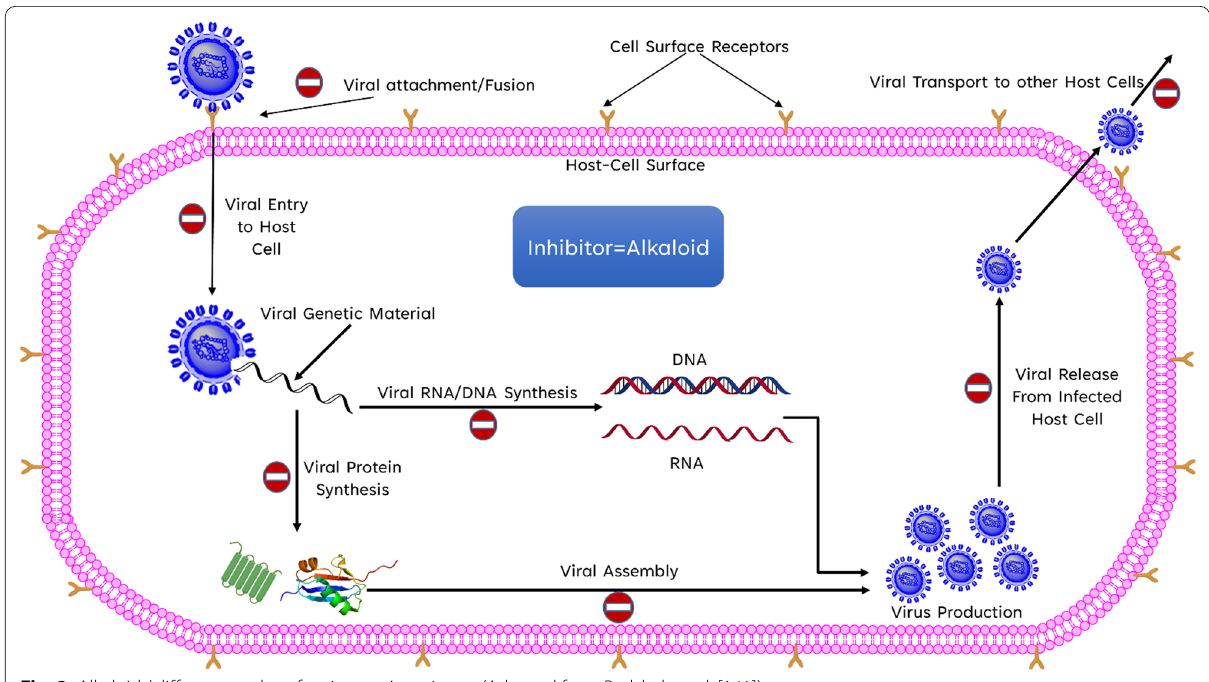
Fig. 2 Alkaloids’ different modes of action against viruses (Adopted from Badshah et al.